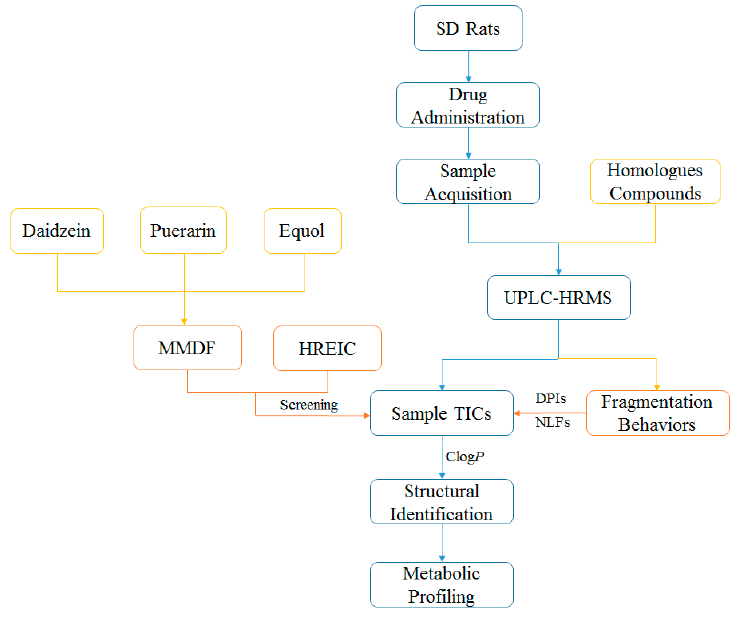
Figure 1. Summary diagram of the developed strategy and methodology.